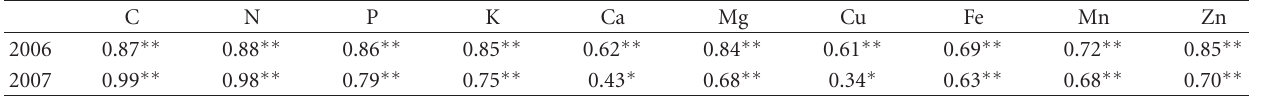
Table 7: Correlation between yield and amount of nutrients for the grain in ten corn cultivars representing five di ff erent technological levels in harvesting in 2006 and 2007, at Rolandia County, Paran´a State,